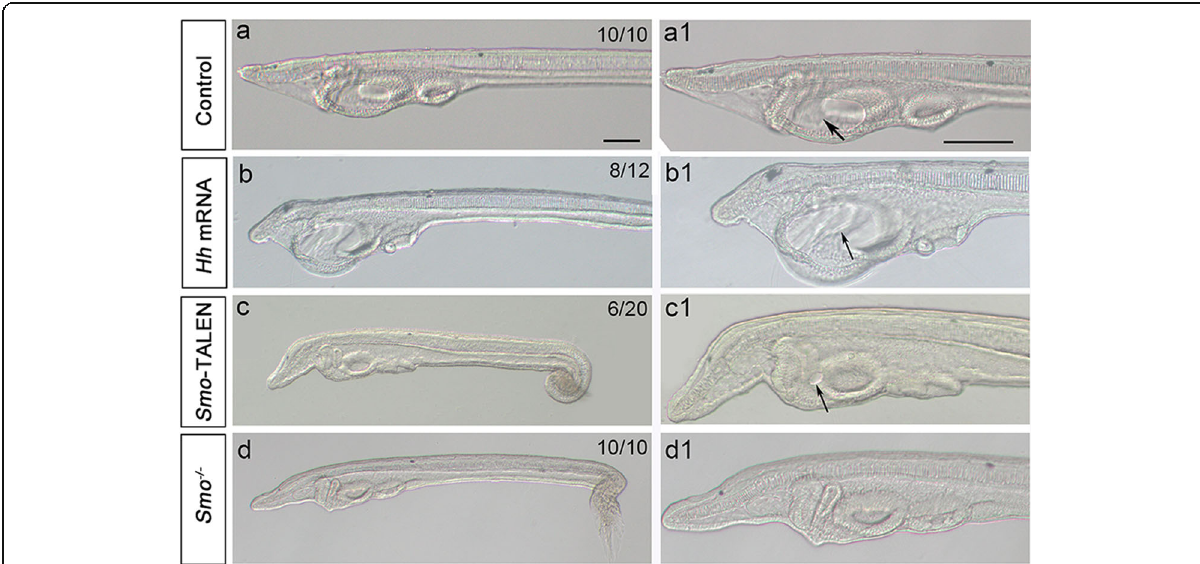
Fig. 5 Hedgehog perturbation affects the size of amphioxus mouth. a, a1: Left lateral view of L1 stage larvae focused on the left-sided mouth opening in control embryos (black arrow), Scale bar, 100 μ m. b, b1: Hh mRNA injection results in a dramatic increase in mouth size. c, c1: Smo -